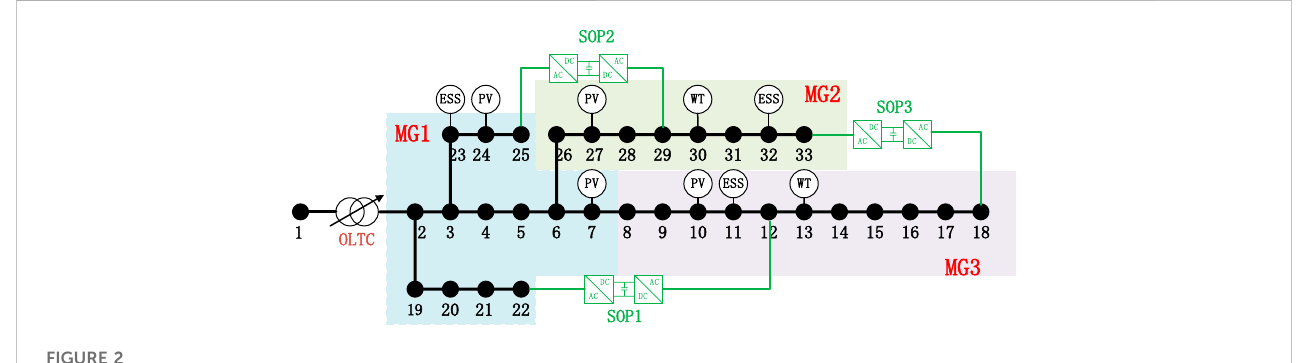
FIGURE 2 Topology diagram of the IEEE 33-bus test system with three microgrids and three